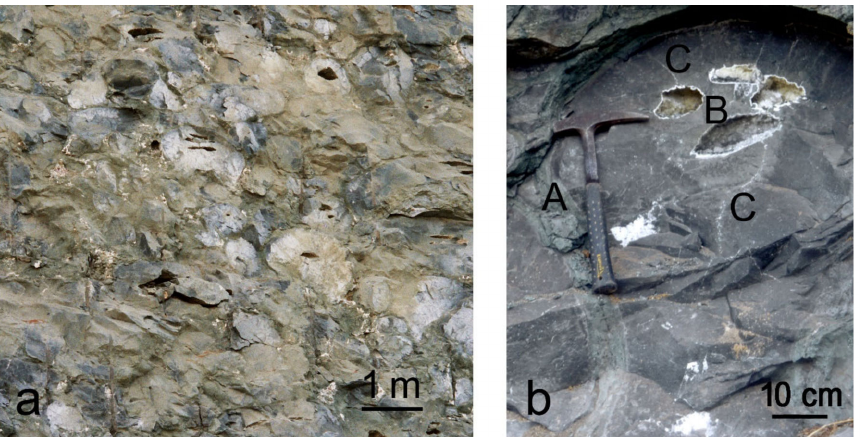
Figure 3. Textures of pillow basalt and hyaloclastite. ( a ) Photograph of a north–south section (north on the left side) of pillow basalt in the Kurar quarry, displaying a sequence of the irregular distribution of pillows and gaps between, filled by strongly altered hyaloclastite and pillow breccia. Cavities occur within pillows and void spaces appear in the breccia. ( b ) Section of a pillow with greenish selvedge (A), several gas blister cavities (B), and radiating cracks (C).